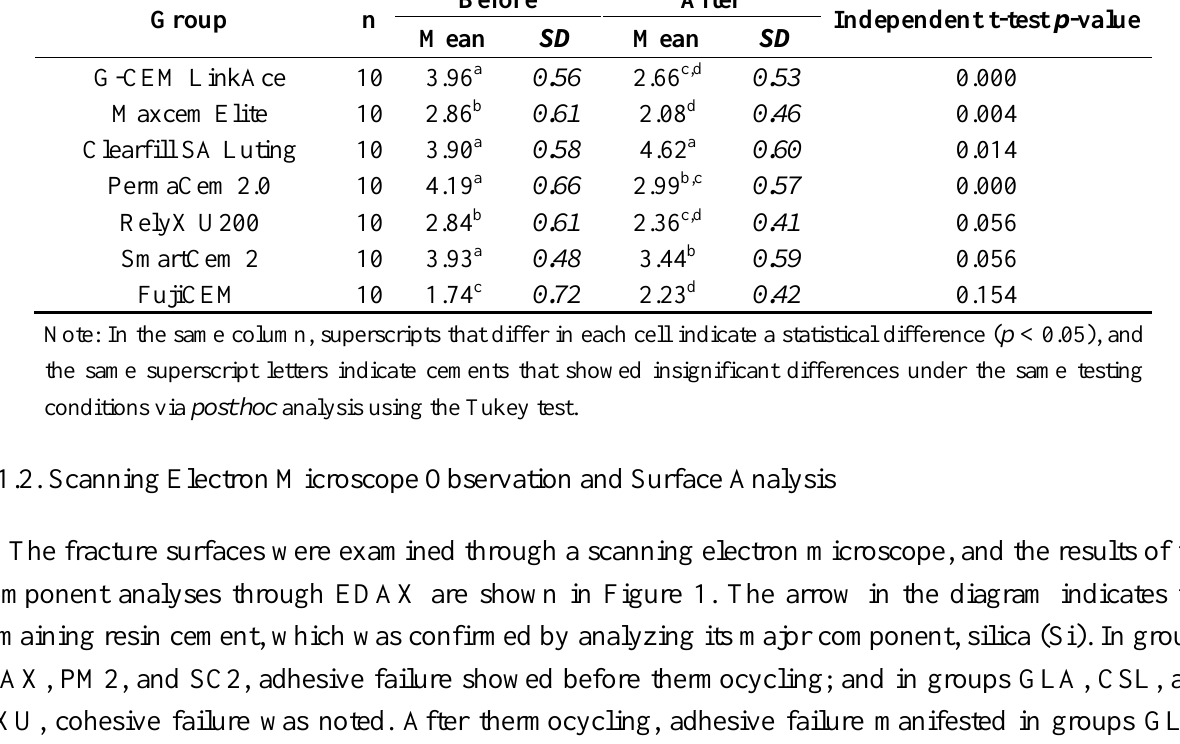
Table 1. Mean shear bond strength values (MPa), standard deviations(SDs), and independent t -test p -values of the cements on the zirconia surface before and after the thermocycling. Before After Group n Independent t-test p -value